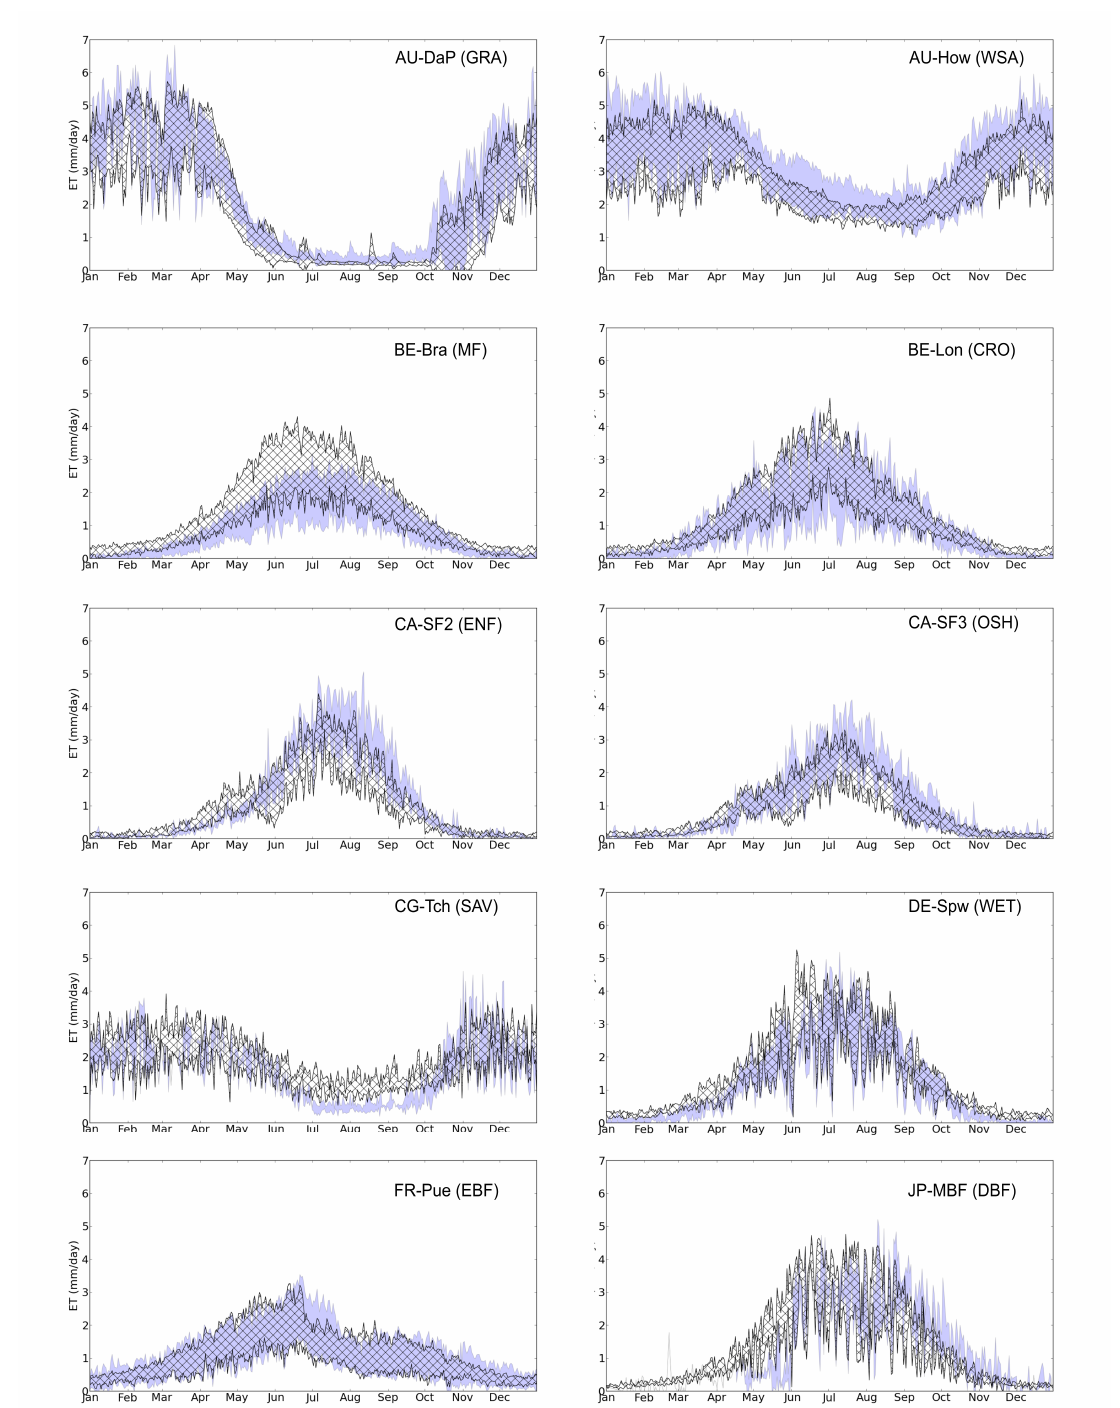
Figure 5. Variability of daily ET as measured at the flux towers (light blue area) and simulated (shaded area). Variability was computed as the average